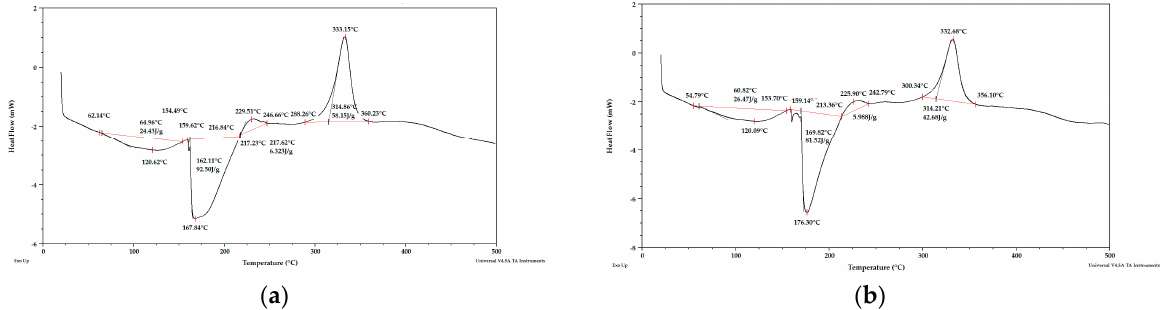
Figure 4. DSC curves for apple pomace dried at 60 °C ( a ) sample 1, ( b ) sample 2. Analysis under nitrogen atmosphere.